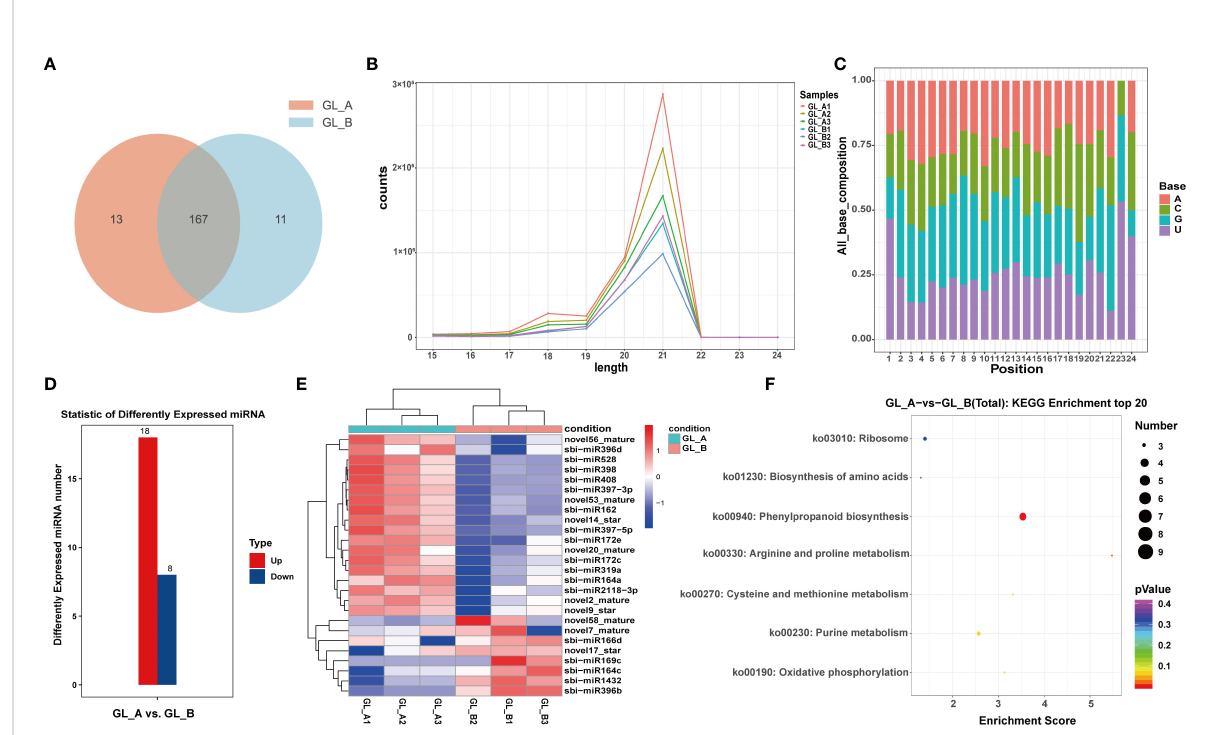
FIGURE 6 Screening and analysis of microRNAs (miRNAs) in the GA 3 -treated sorghum ( “ Jitian 3 ” ) under salt stress. (A) Venn diagram illustrating the number of miRNAs in GA 3 -treated (GL_A) and control (GL_B) samples. (B, C) Sequence length distribution of small RNAs isolated from the six sorghum leaf libraries (A) and the nucleotide compositions of the mature miRNAs (B) ; GL_A1, GL_A2 and GL_A3 refer to the three GA 3 -treated sample replicates; GL_B1, GL_B2 and GL_B3 refer to the three control sample replicates. (D) Statistic analysis of the number of differentially expressed miRNAs (DE-miRNAs) in the GL_A and GL_B groups; Red represents upregulation in GL_A group, while blue represents downregulation in GL_A group. (E) Heatmap analysis of DE-miRNAs among the six miRNA sequencing libraries. (F) KEGG network enrichment analysis of all DE-miRNAs